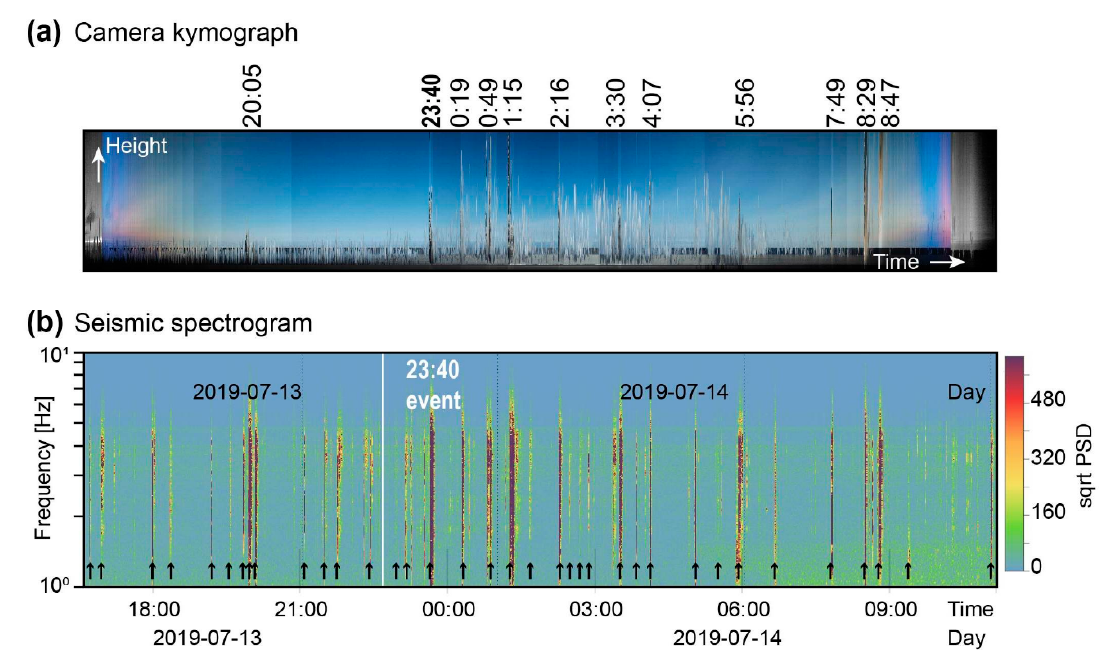
Figure 4. Instrumental records. ( a ) Camera kymograph generated by the vertical RGB line ( y -axis) versus time ( x -axis) shows 12 main eruptions on one day (dusk to dawn on 2018-07-13 to 2018-07-14 UTC). The first large event after > 3-h of quiescence occurred at 23:40. ( b ) Spectrogram generated for seismic station show clear explosion occurrences (dark vertical lines). The events picked using the LTA-STA trigger are indicated by small black arrows. Eruption at 23:40 monitored closely by the UAS is highlighted by white timing. Note that the occurrence of eruption multiplets (at 20:06 and 8:29) was preceded and followed by pronounced lag times.